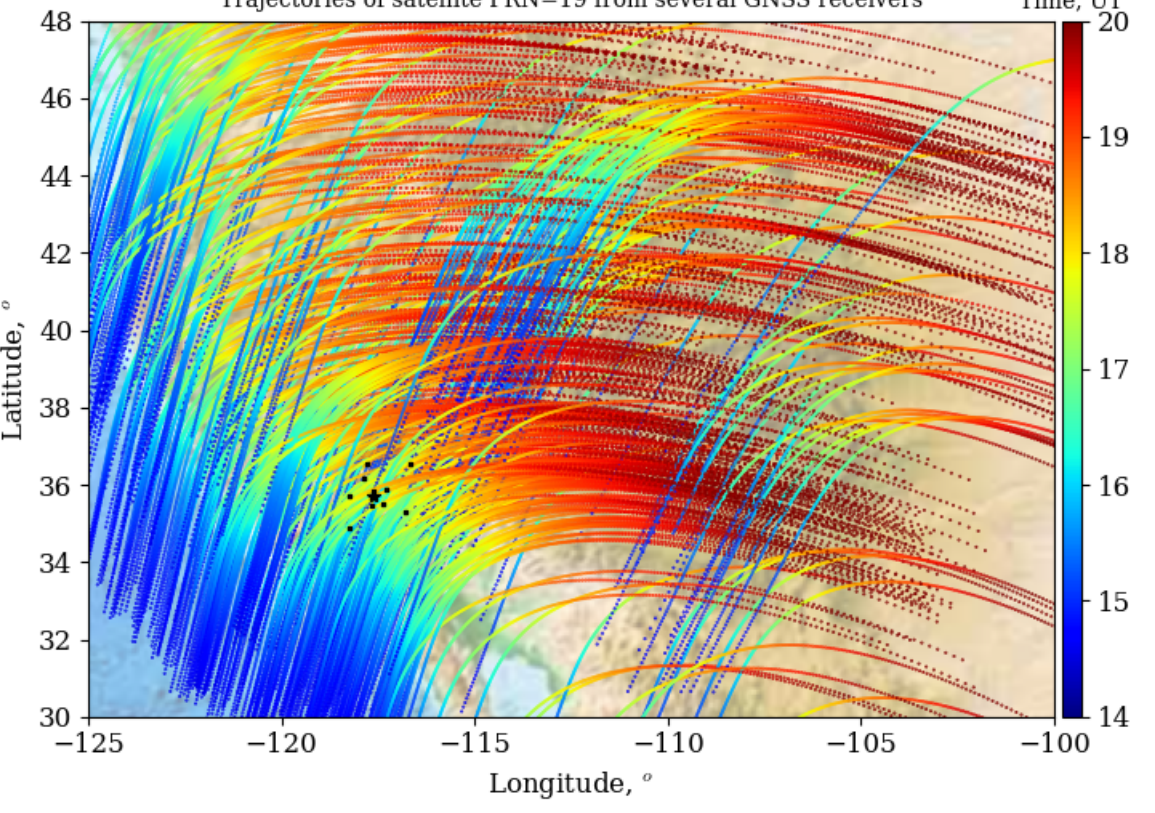
Figure 1. The IPP trajectories of the GPS satellite PRN19 registered by 600 GNSS receivers. The color code represents an observation time between 14 and 20 UT. The star and squares represent earthquake epicenter and seismic stations,